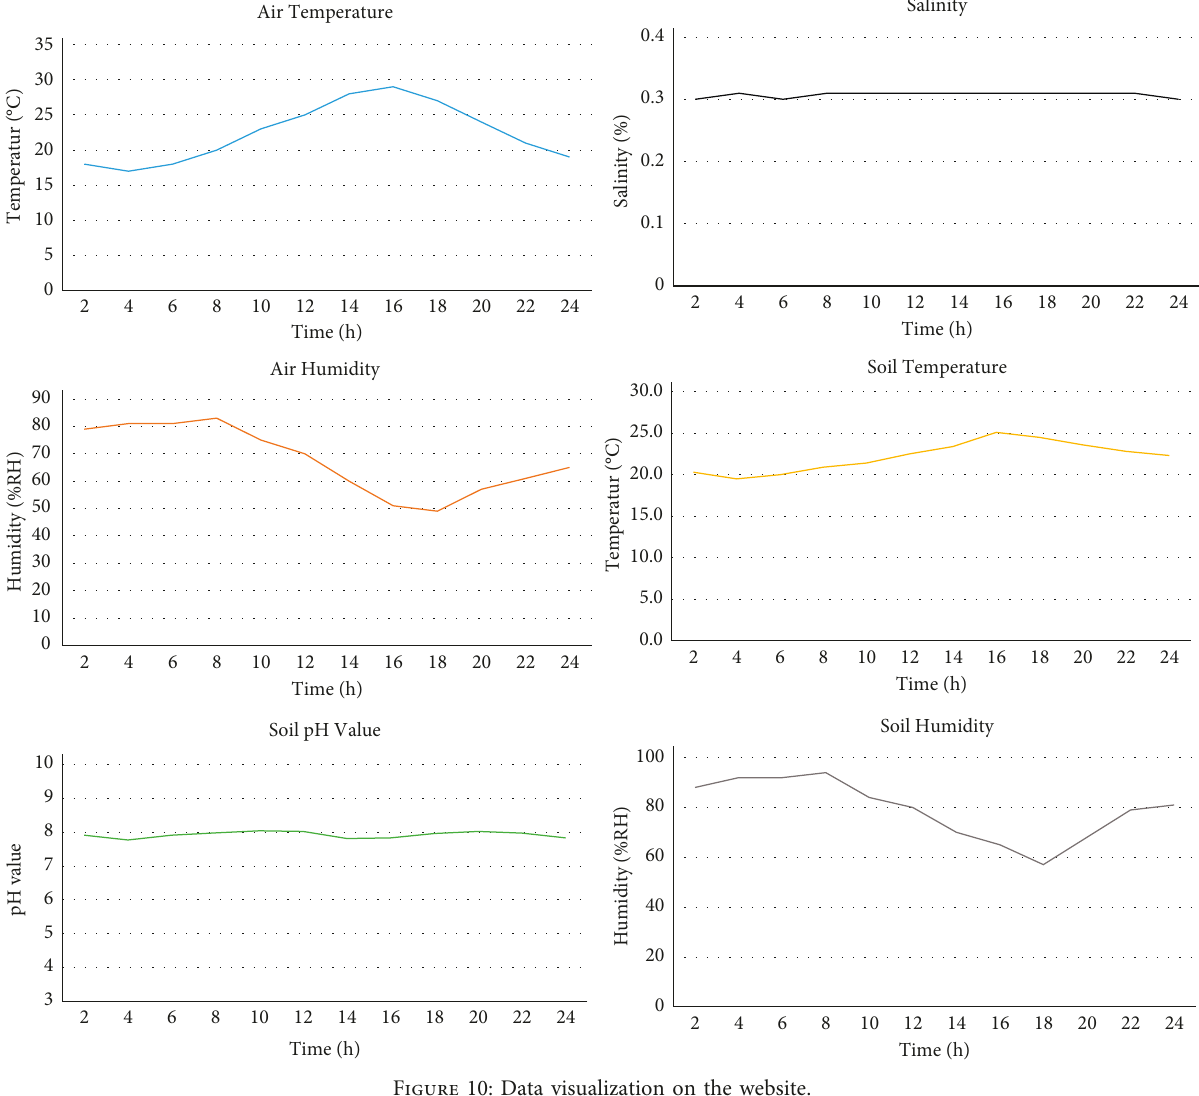
Figure 10: Data visualization on the website.